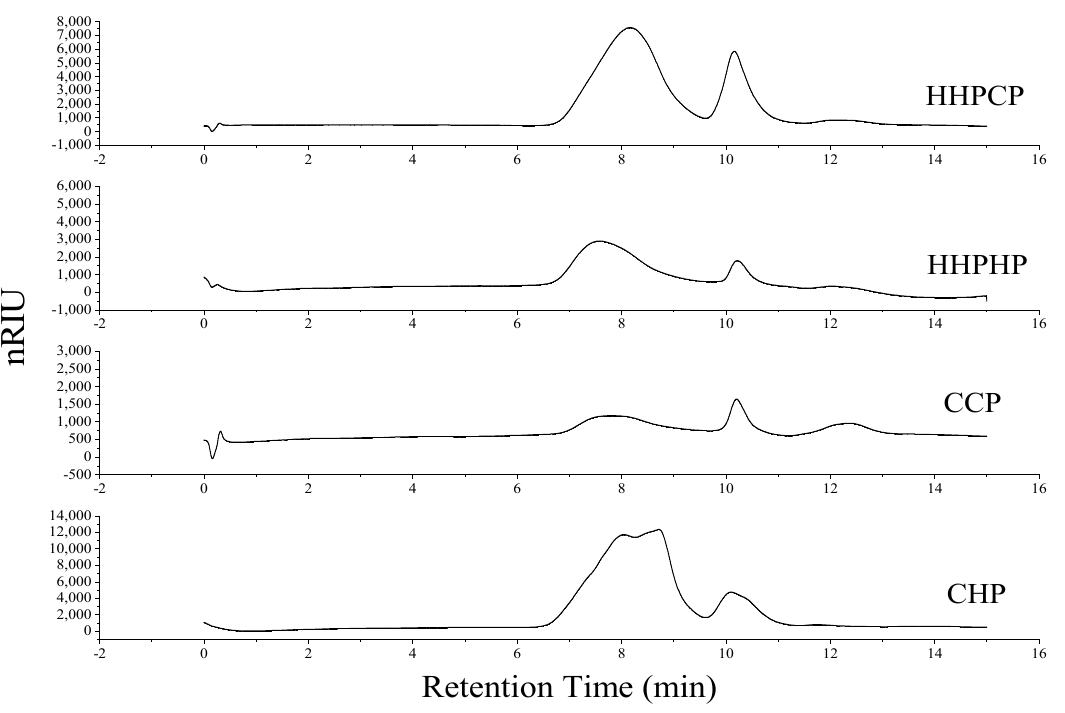
Figure 2. Effect of different extraction methods on molecular weight distribution of Satsuma man- darin peel pectin. peel